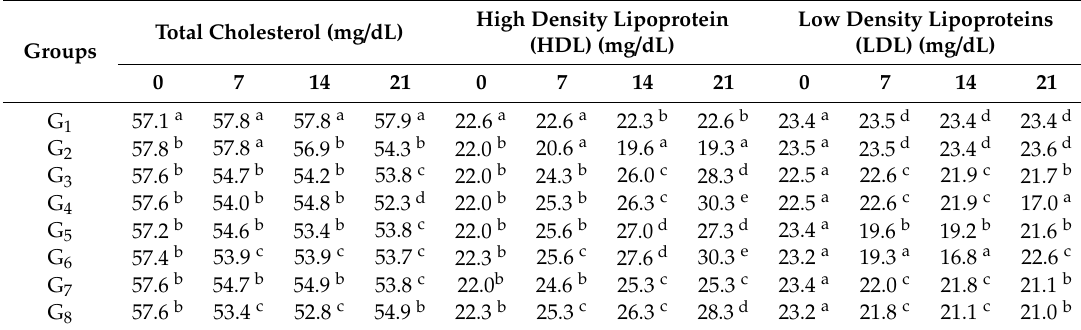
Table 2. Biochemical and blood serum characteristics of mice fed with and without the supplementation of guava extracts during 3 weeks of administration.